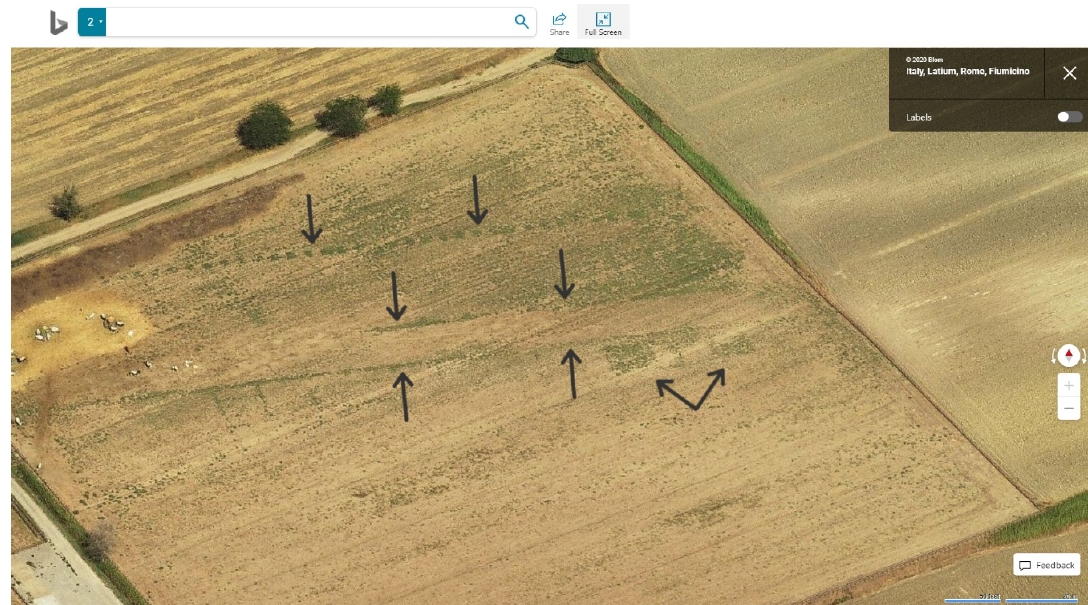
Figure 10. An example of archaeological cropmarks with one positive detection. These structures are similar to those identified by an extensive magnetometry survey published by Keay et al. in 2005 [52]. In this survey, the dotted lines traversing east to west have been interpreted as an aqueduct and the lines parallel to the dotted line as a gravel road, both traversing from the hexagonal port of the Roman emperor Trajan to the Tiber river. The cropmarks below the road have been interpreted as various constructions. The black arrows point to some of these features. The Microsoft product screenshot is reprinted with permission from Microsoft Corporation.